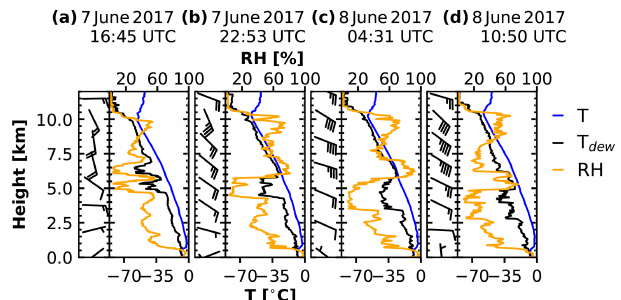
Figure 15. Same as Fig. 9 but for 7 June 2017 21:00UTC–8 June 2017 09:00UTC up to 12km height.